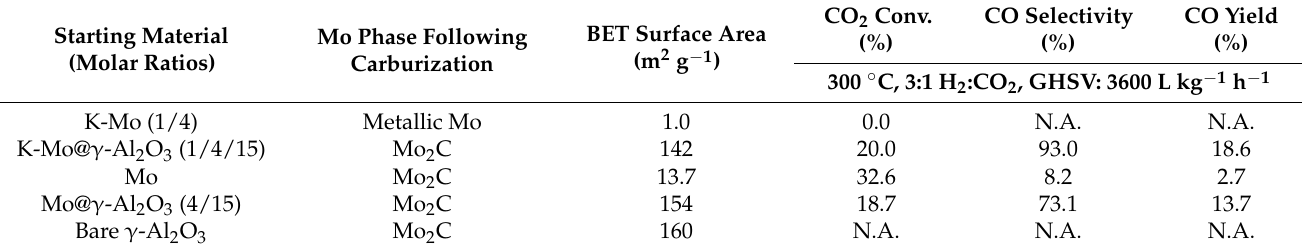
Table 1. Performance of Mo-based catalysts with and without γ -Al 2 O 3 and potassium promoter. All catalysts were tested under the following conditions: 3:1- H 2 :CO 2 ratio at 300 ◦ C, 2.0 MPa, and at a GHSV of 3600 L kg − 1 h − 1 .